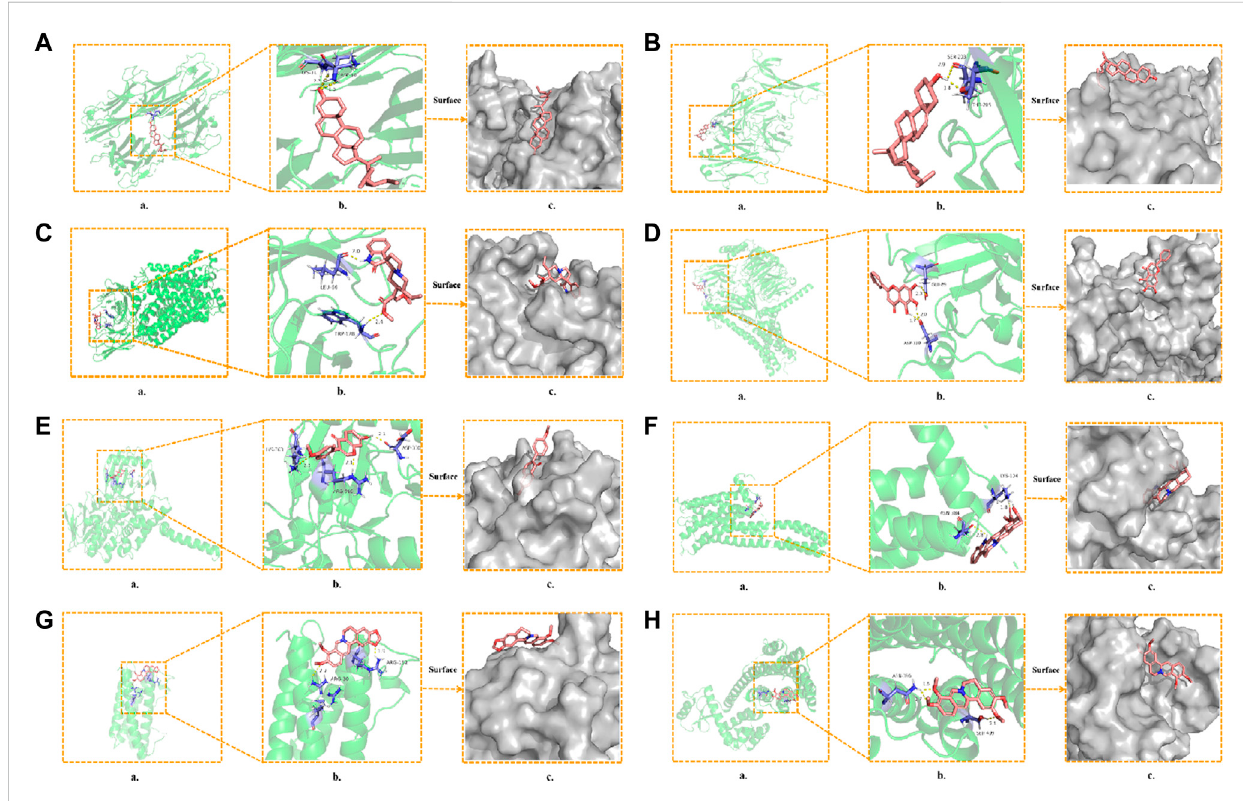
FIGURE 5 Molecular docking model diagram (A) Beta-sitosterol — TNF (B) Stigmasterol — NGF (C) Rhynchophyllin — SLC6A4 (D) Baicalein — DRD1 (E) Formononetin — MAOA (F) Yohim-bine — HTR2A (G) Berberine — IL6 (H) Palmatine — DRD2. (a) Molecular docking model, the red represents the 3D structureofthecomponentligand,thegreenrepresentsthe3Dstructureofthetargetreceptor,andthebluerepresentstheaminoacidresidues(b)Inthe enlarged structure of the docking site, the yellow represents the hydrogen bond formed between the ligand and the amino acid residue, and the numberrepresentsthebondlength(c)Combinationdiagramofthesurfacestructureofthetargetreceptorandthecomponentligand,theredrepresents the 3D structure of the ligand, and the gray represents the receptor surface structure.